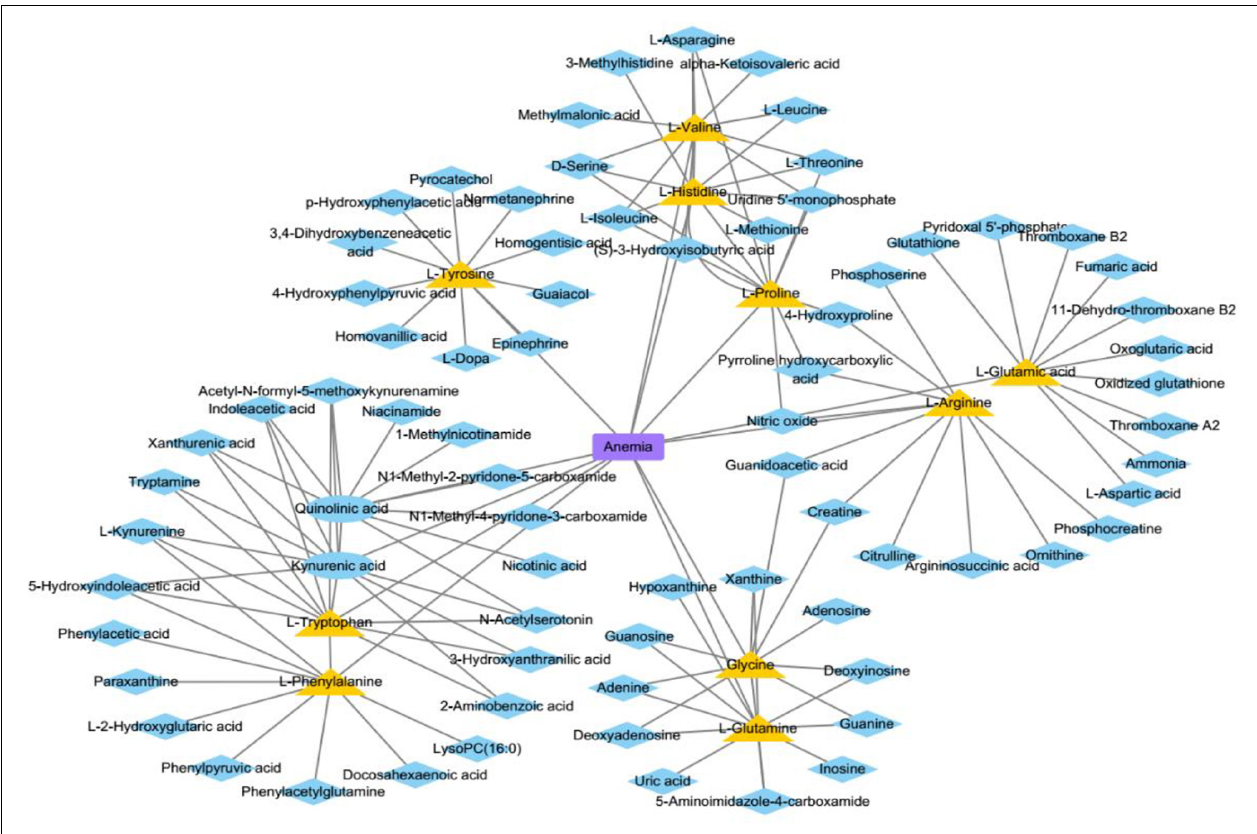
FIGURE 10 | The associations between anemia and some metabolites. The blue ellipses represent the known metabolites about anemia in this study. The yellow triangles represent the top 10 predicted metabolites relevant to anemia. The blue diamonds represent the top 10 neighbors about predicted or known metabolites.